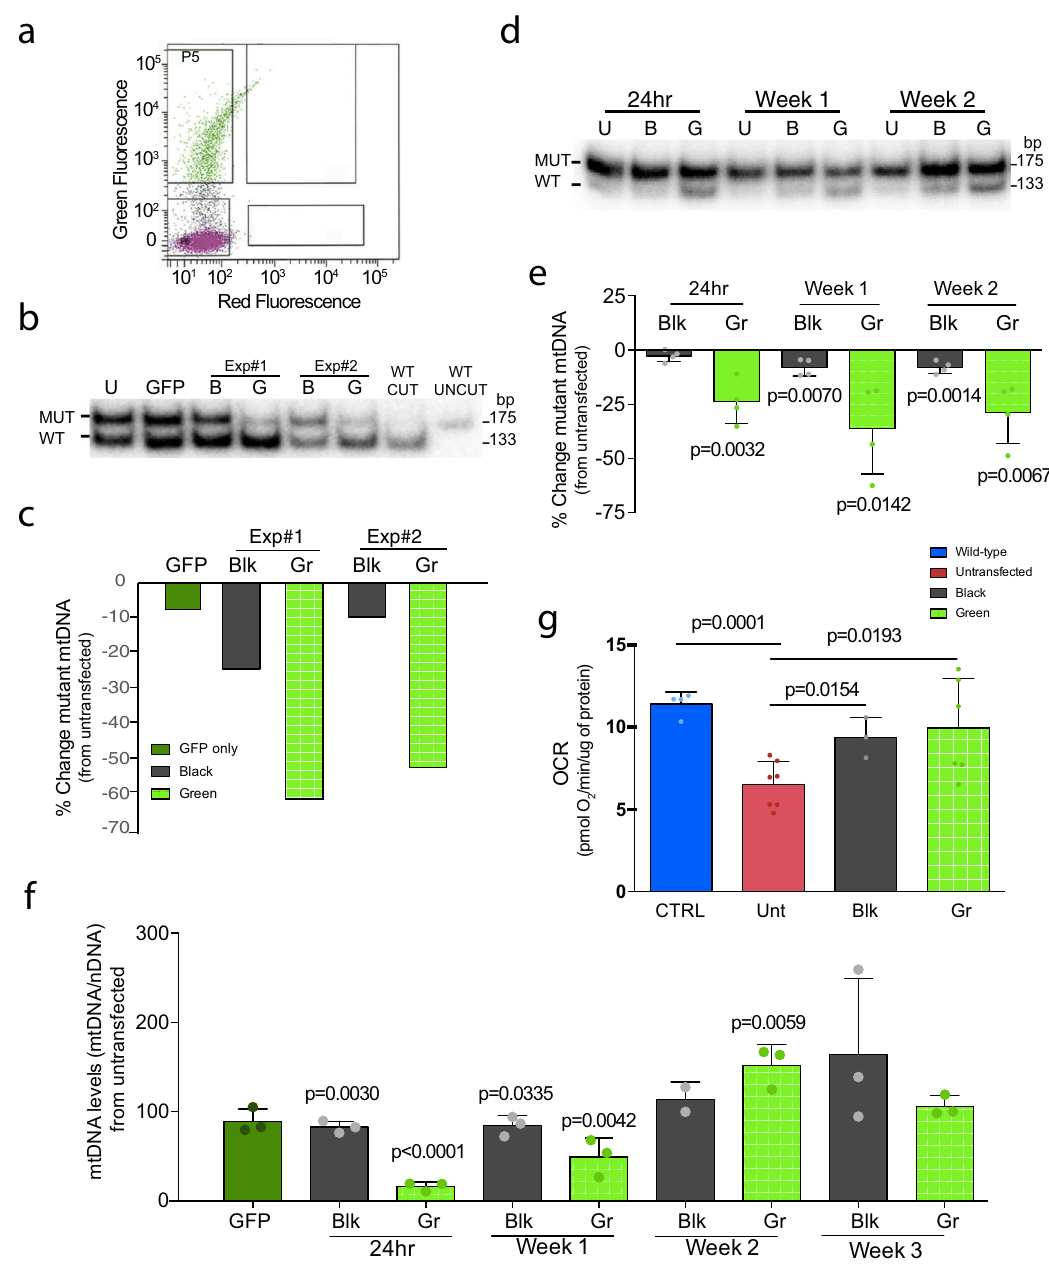
Fig. 2 mitoARCUS effect on heteroplasmic cells carrying the tRNAAla mutation (m.5024C>T). a Example of FACS cell sorting gating. Cells were sorted by the presence of GFP co-expression: “ Black ” cells (bottom gate) and “ Green ” cells (top gate). b RFLP-HOT PCR analysis of two independent transfections and cell-sorting experiments of heteroplasmic cells carrying 50% m.5024C>T mutation. Mutant levels in the Green cell populations (Gr) were compared to Untransfected cells (U). This experiment was done once. c Quanti fi cation of heteroplasmy shift from the two cell-sorting experiments in cells carrying 50% mutation described in b . Results were compared to Untransfected cell heteroplasmy. d RFLP “ last-cycle hot ” PCR analysis of heteroplasmic cells carrying high heteroplasmic mutant load (90%) transfected with mitoARCUS over time. This experiment was repeated three times with similar results. e Quanti fi cation of Fig. 2d. Values are normalized to Untransfected cells. Black cells are named Blk ( n = 4). f Total mtDNA levels were checked in highly mutant cells transfected with mitoARCUS and compared to untransfected cells 24 h after transfection, and followed for 3 weeks after transfection ( n = 3). p values are related to untransfected cells (100%). g Oxygen consumption rate (OCR) was deduced in cells carrying high levels of heteroplasmic mutant mtDNA that were transfected with mitoARCUS and grown for 3 weeks [ n = 3 (CTRL), n = 7 (Unt), n = 3 (Blk), n = 7 (Gr)]. Data are mean ± SEM. Statistical analysis was performed using two-tailed Student ’ s t AAV9-mitoARCUS-injected, AAV9-GFP-injected, and non- injected controls (Supplementary Fig. 4).